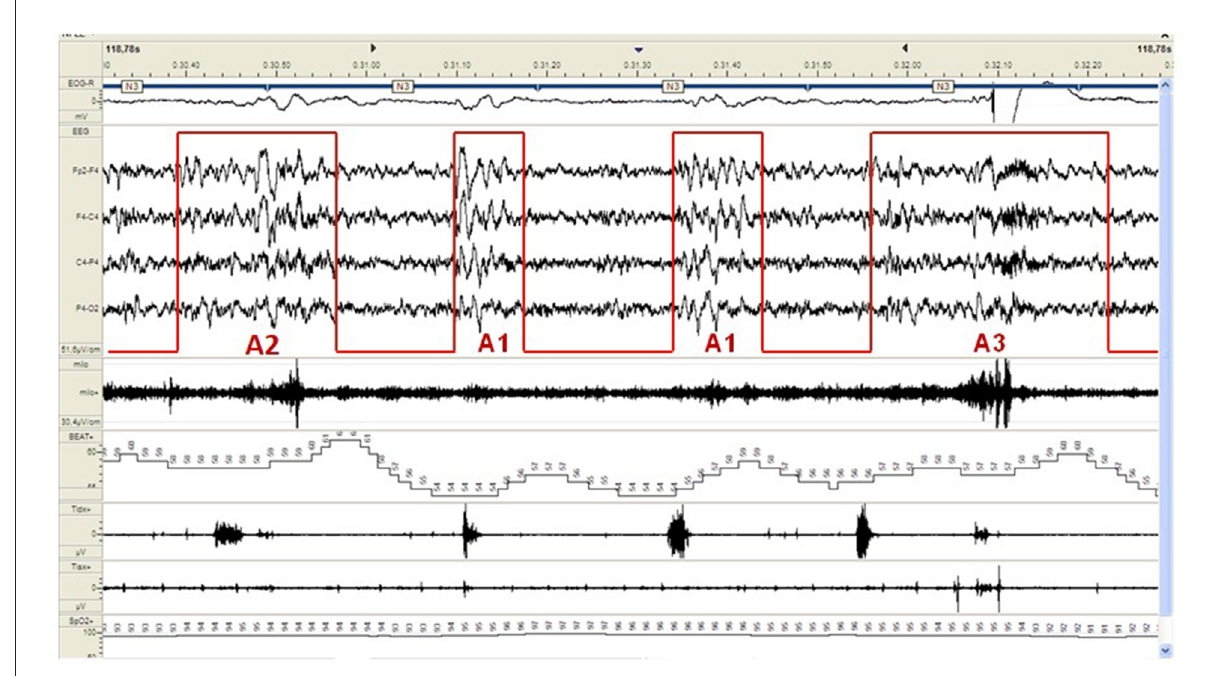
FIGURE2 Example of a CAP sequence (CAP phases A highlighted in red) during stage N3 of NREM sleep in a patient affected by periodic limb movement disorder (PLMD). Note that the more disturbing leg movements (right part of the figure) are associated with CAP subtype A3. CAP subtypes A1 have a milder cardiovascular